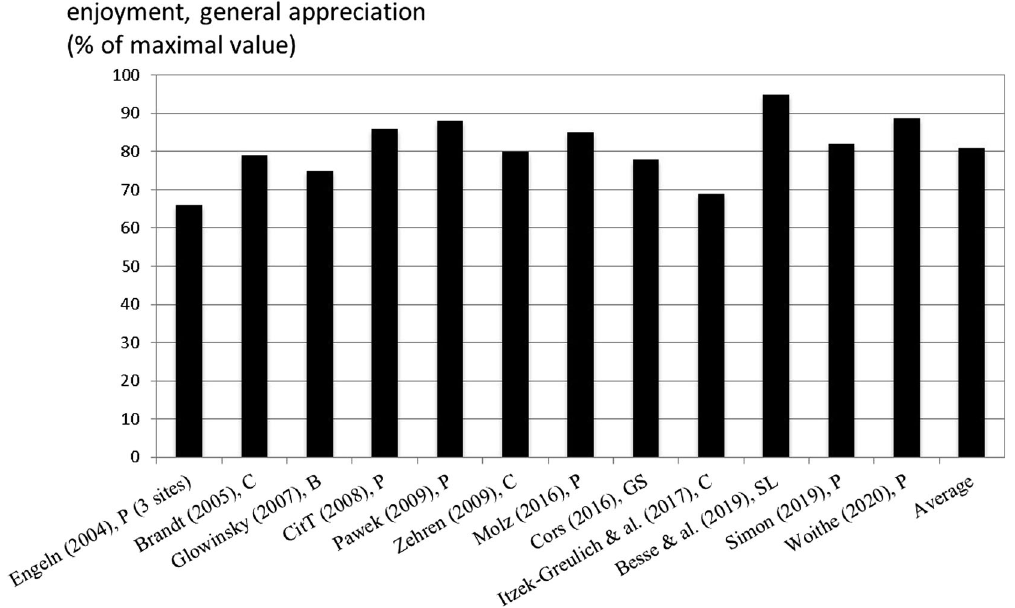
FIG. 1. Enjoyment or general appreciation of various science outreach labs as percentage of maximal possible score value ( “ POMP ” [38]). Abbreviations: B: biology; C: chemistry; P: physics; GS: science (general); SL: scientific literacy; rightmost column: average [32,33,39 –